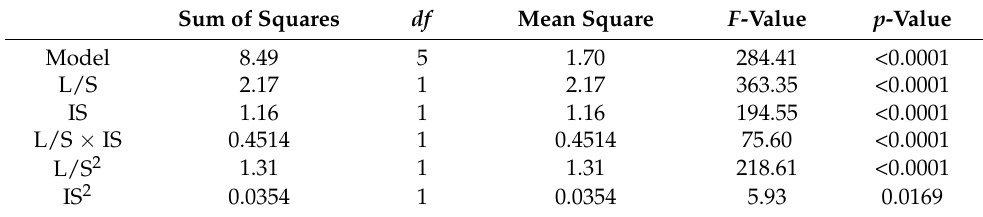
Table 3. Analysis of variance for the d mean model and individual variables.